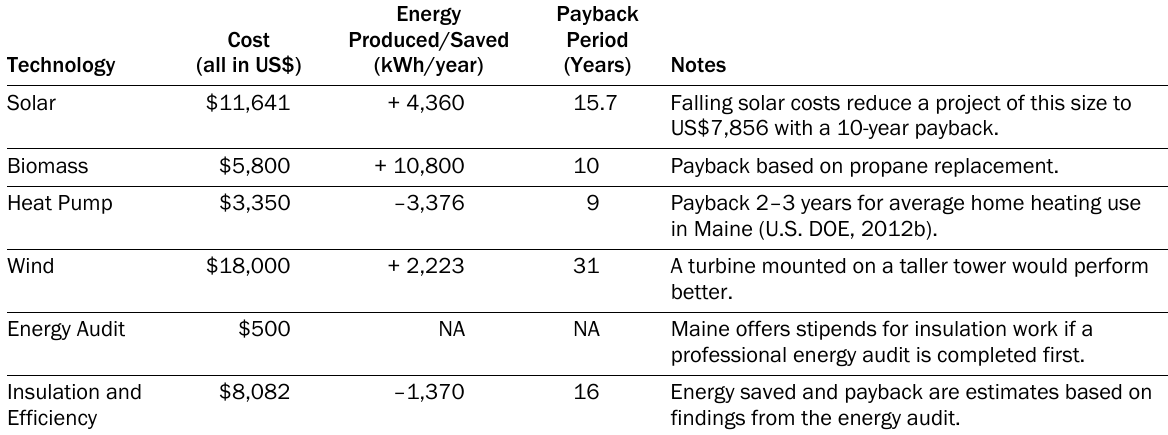
Table 2. Cost and Payback for Demonstration Project Measures